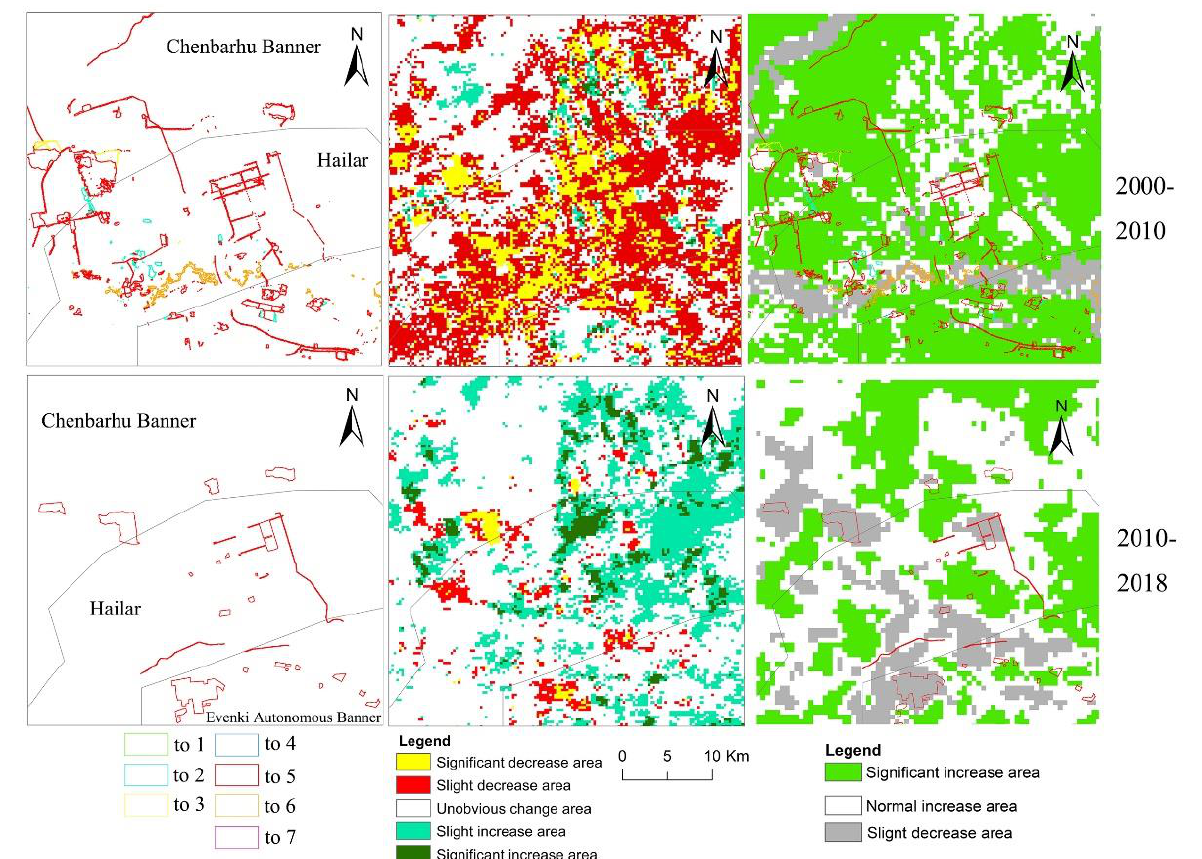
Figure 12. Spatiotemporal change in land cover and ecological quality in Hailar District: 1 represents forest; 2 represents grassland; 3 represents farmland; 4 represents wetland; 5 represents urban land; 6 represents desert; 7 represents burned land; “to 1” represents the change from other land cover types to forest; and “to 2” represents the change from other land cover types to grassland.